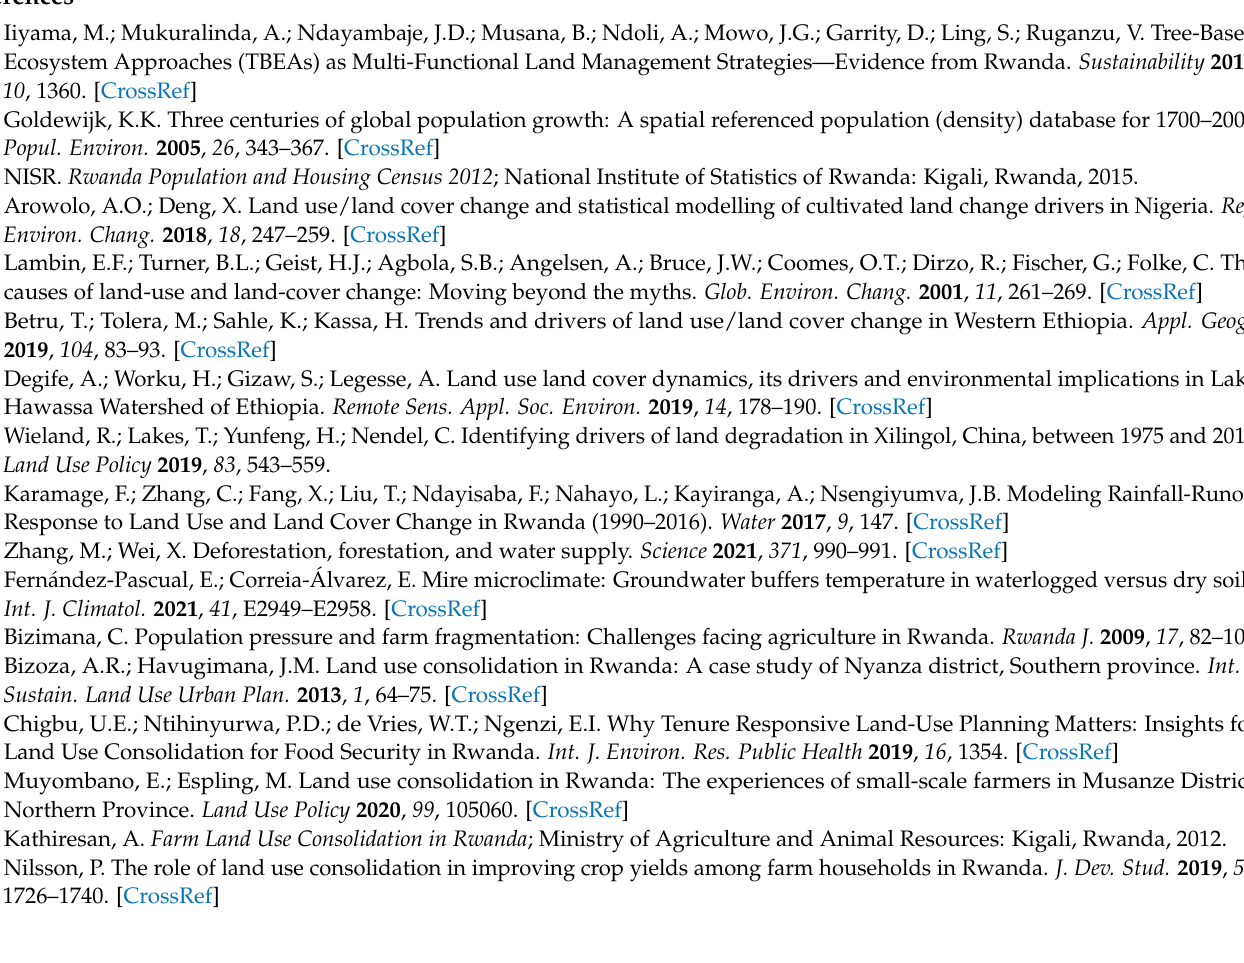
Figure A2. Land use structure composition of six agro-ecological zones: ( a ) Eastern Savanna; ( b ) Eastern Plateau; ( c ) Bubureka Highland; ( d ) Central Plateau and Collines; ( e ) Volcanic Highland; ( f ) Congo-Nile Crest.